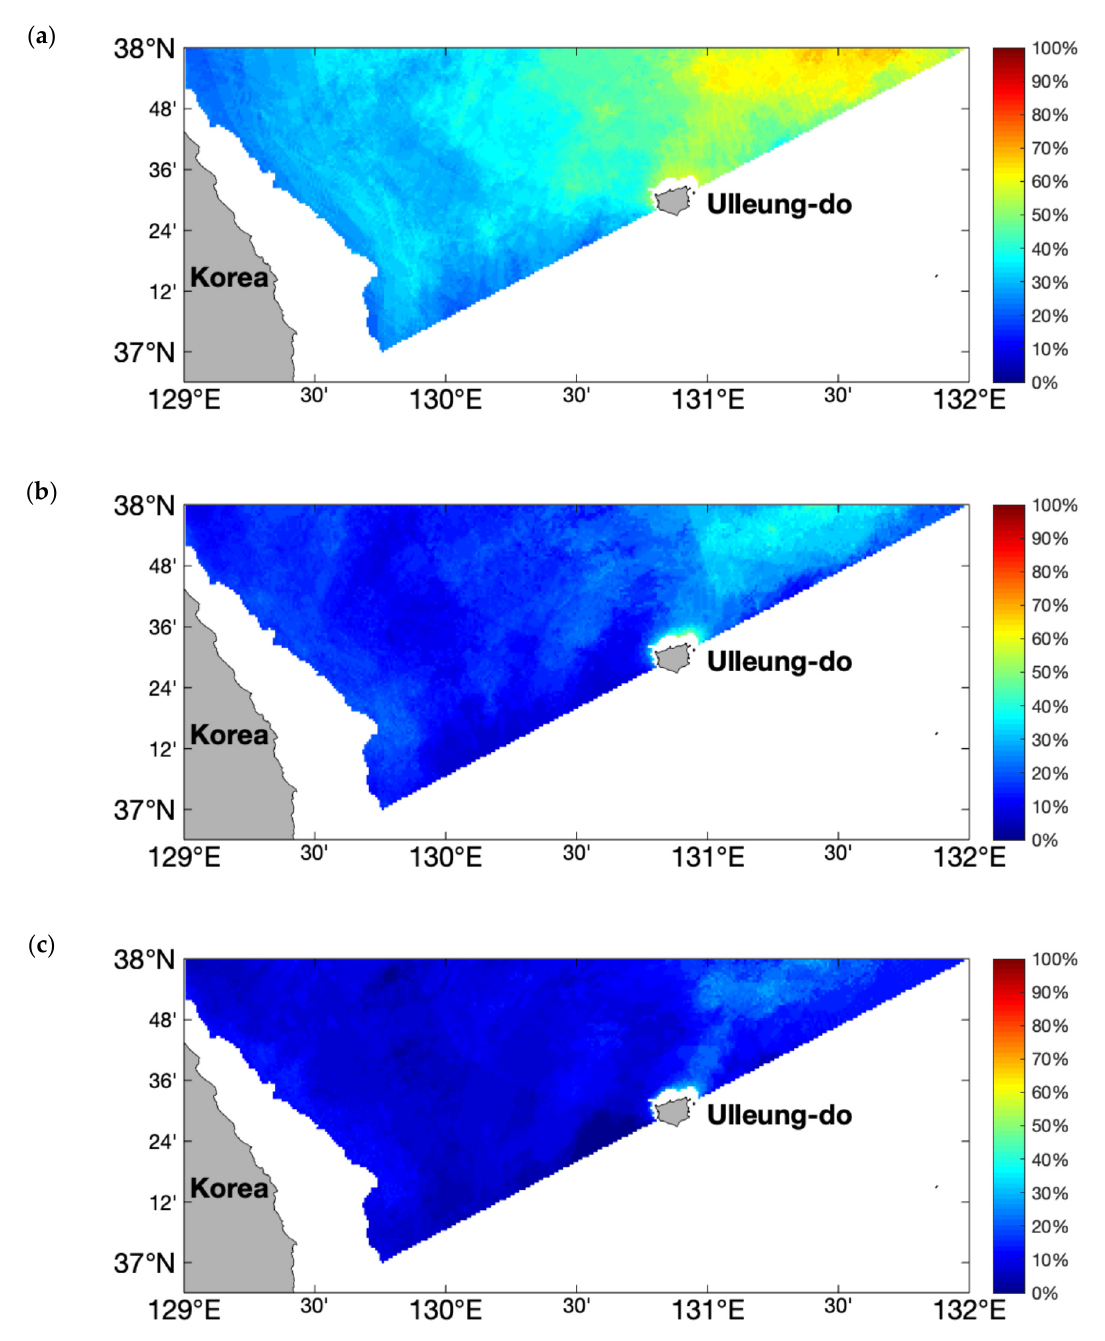
Figure 10. The product of MLE and the probability of tsunami travel time within 1.5 h after the earthquake. Probability results for ( a ) 0.1 m, ( b ) 0.2 m, and ( c ) 0.3 m maximum tsunami